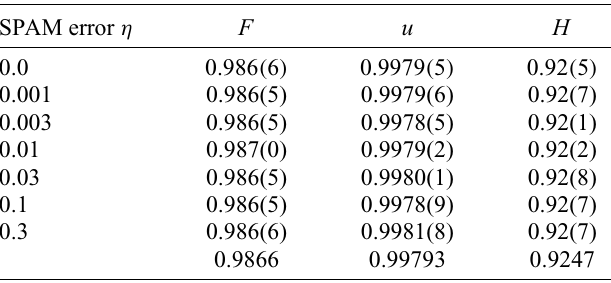
TABLE IV. The estimates of F , u , and H from the numerics shown in Fig. 7. The parameter η is for SPAM errors such as = η ( 0 | 1 ) = η ( 1 | 0 ) . The theoretical values are η = η prep meas meas listed at the bottom of the